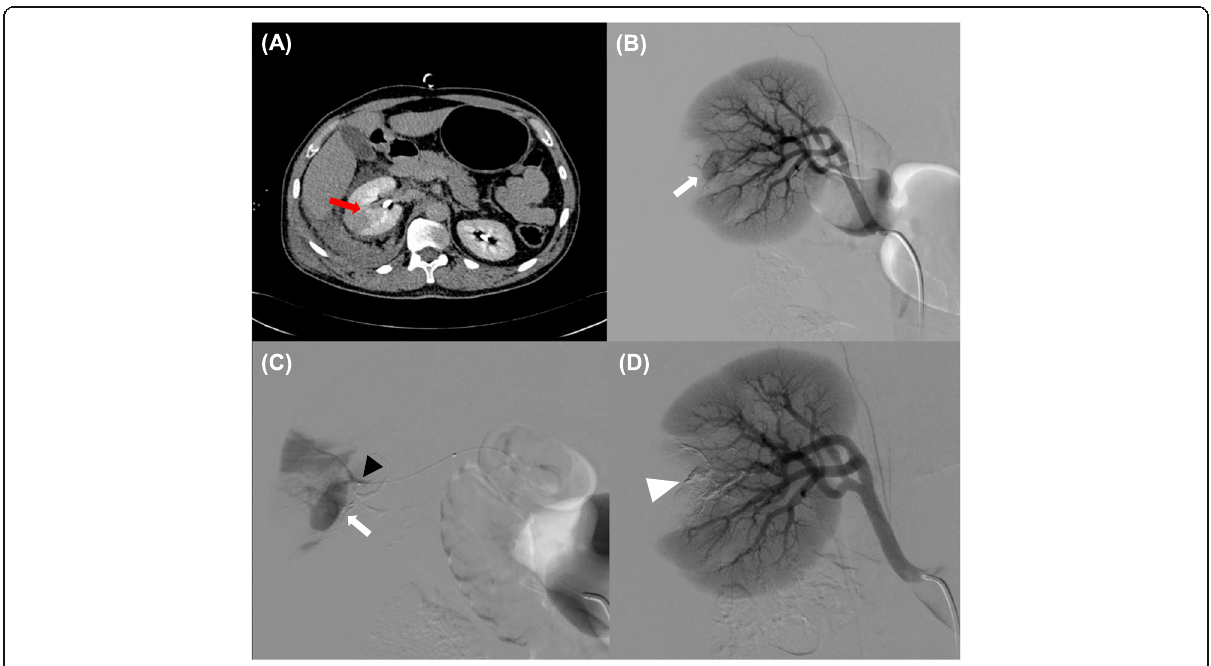
Fig. 1 ( a ) Computed tomography ( CT) image after endovenous contrast injection, depicting contrast deposition inside the right kidney. ( b ) Digital subtraction angiography (DSA) with injection from right renal artery showing pseudoaneurysm (white arrow), best seen in image ( c ) with